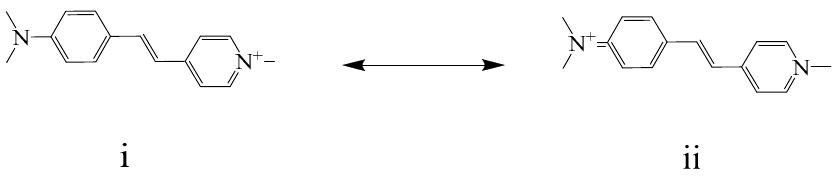
Figure 12. Two kinds of dimethylamino-styryl-pyridinium conjugate forms.